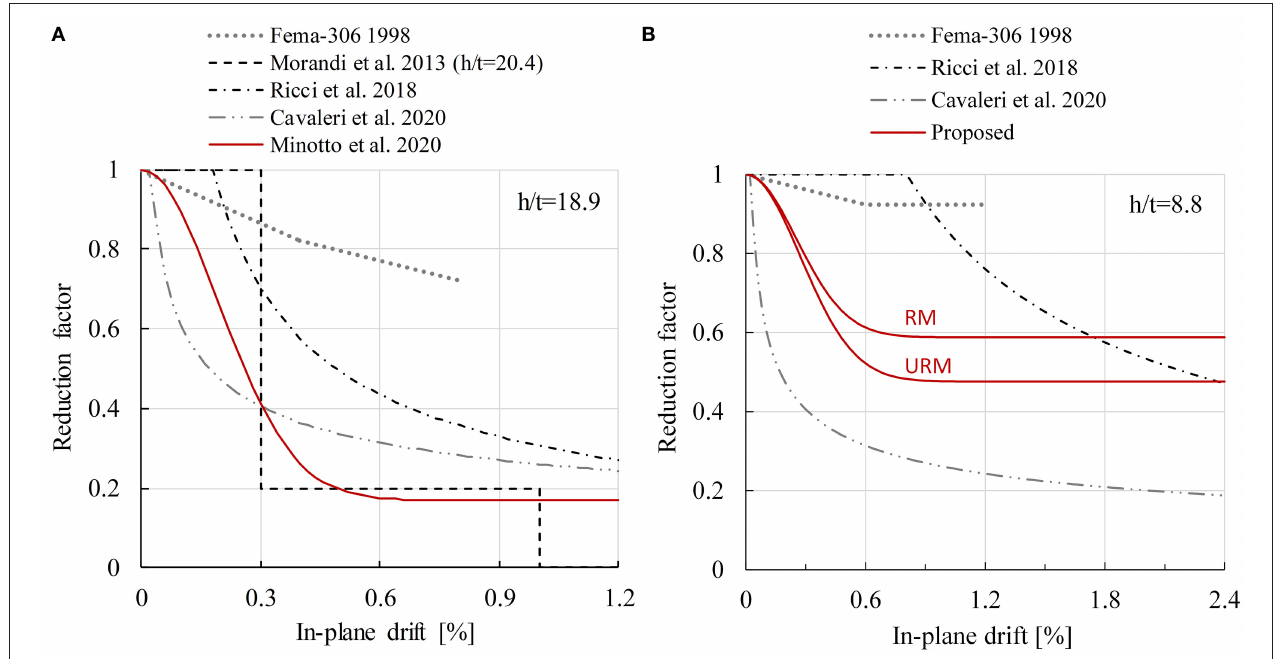
FIGURE 19 | Comparison of the out-of-plane strength degradation laws of slender (A) and squat (B) infill